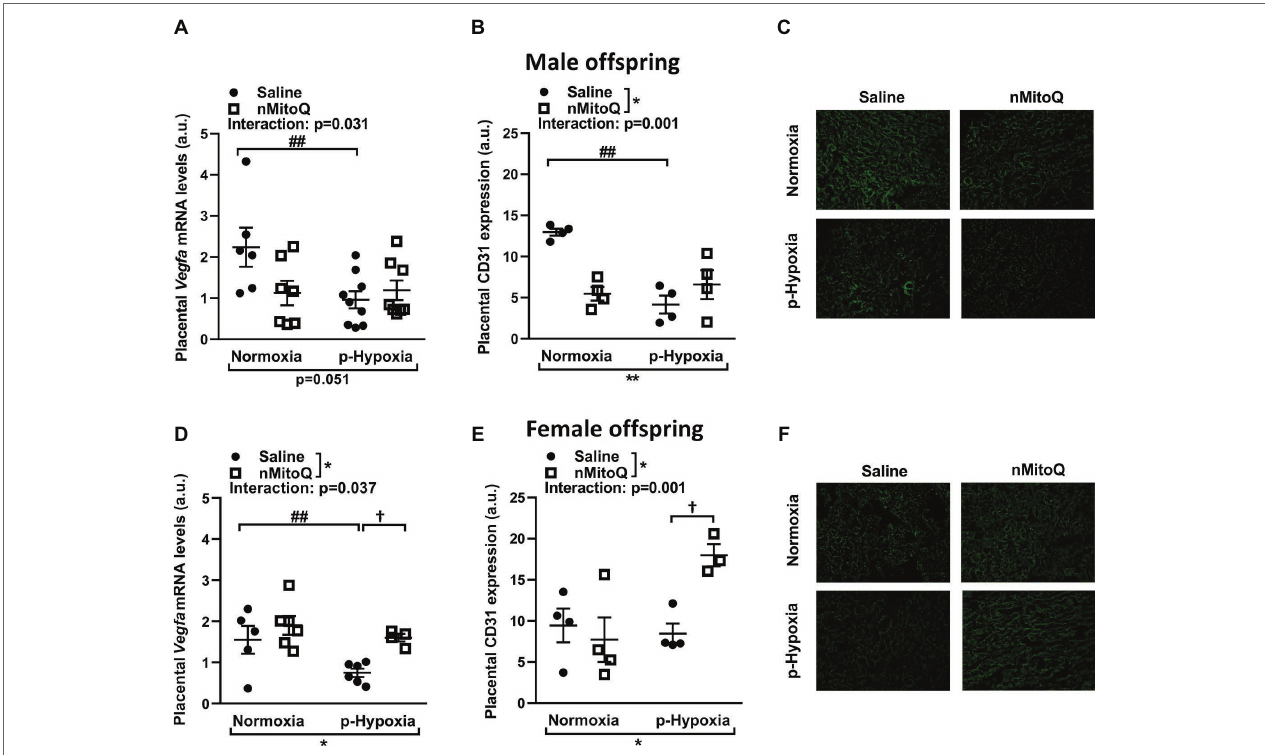
FIGURE 3 | Effects of nMitoQ treatment on markers of angiogenesis and vascularization in prenatally hypoxic placentae of both male female offspring. Proangiogenic factor Vegfa mRNA levels were assessed by qPCR in placental tissue obtained from male (A) and female (D) fetuses on GD21. Feto-placental vascular capillaries as assessed by CD31 staining in placentae obtained from male (B) and female (E) fetuses. Representative images of CD31 stained placental labyrinth sections in placentae of male (C) and female offspring (F) . Data are represented as mean ± SEM. a.u.: arbitrary units. All groups were compared using a two-way ANOVA followed by Sidak’s post hoc test ( n = 5–9/group). * p < 0.05, ** p < 0.01 group effect of prenatal hypoxia and nMitoQ treatment; ## p < 0.01 compared to normoxia-saline; † p < 0.05 compared to hypoxia-saline